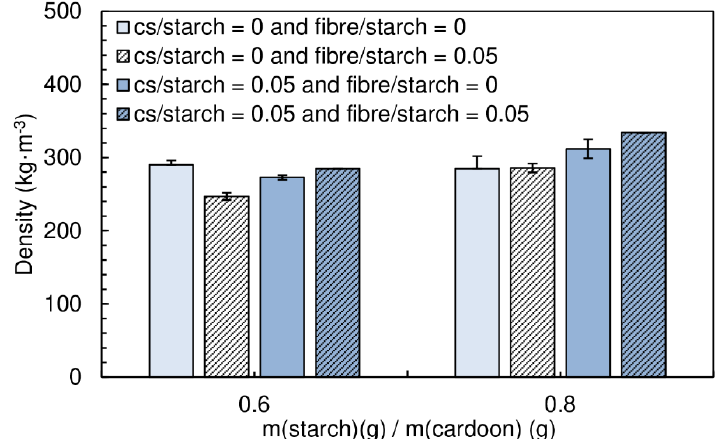
Figure 6. Density of the particleboards produced with fiber and fiber combined with chitosan. All adhesive formulations had a starch/cardoon ratio of 0.6 and 0.8.